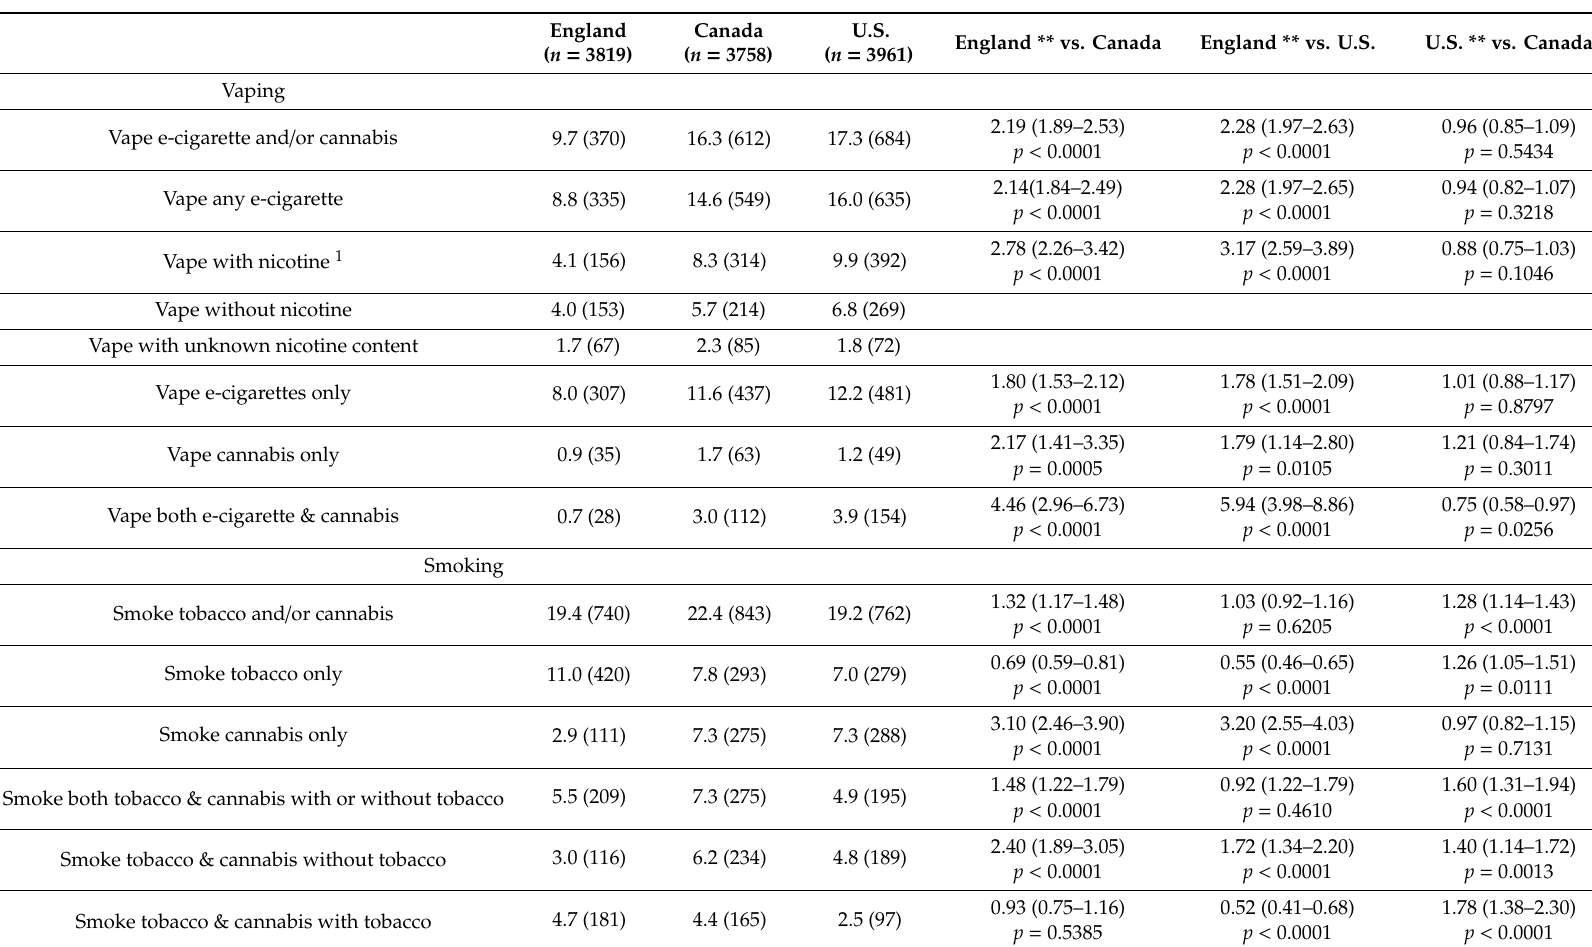
Table 4. Prevalence of past 30-day tobacco and cannabis use among all youth and binary logistic regression for outcome variables by country (weighted)